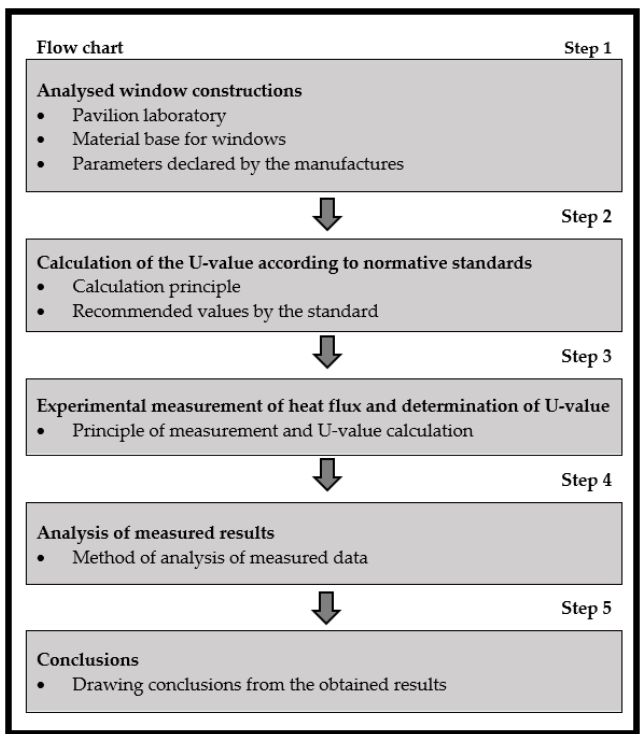
Figure 1. Flowchart of the analysis process.